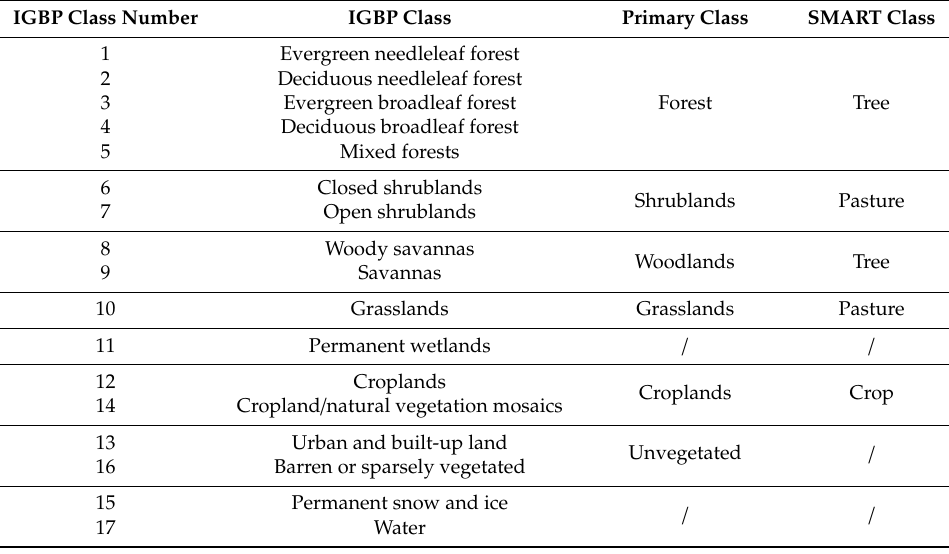
Table 3. Land Cover Classes Used in this